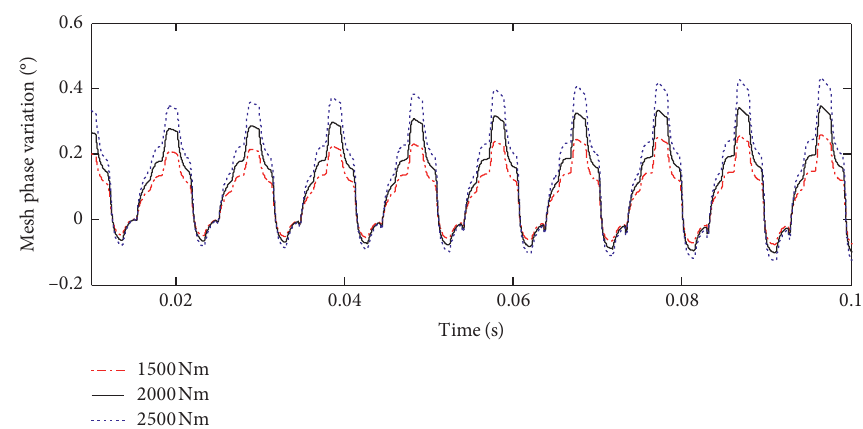
Figure 16: Meshing phase variation of s- p